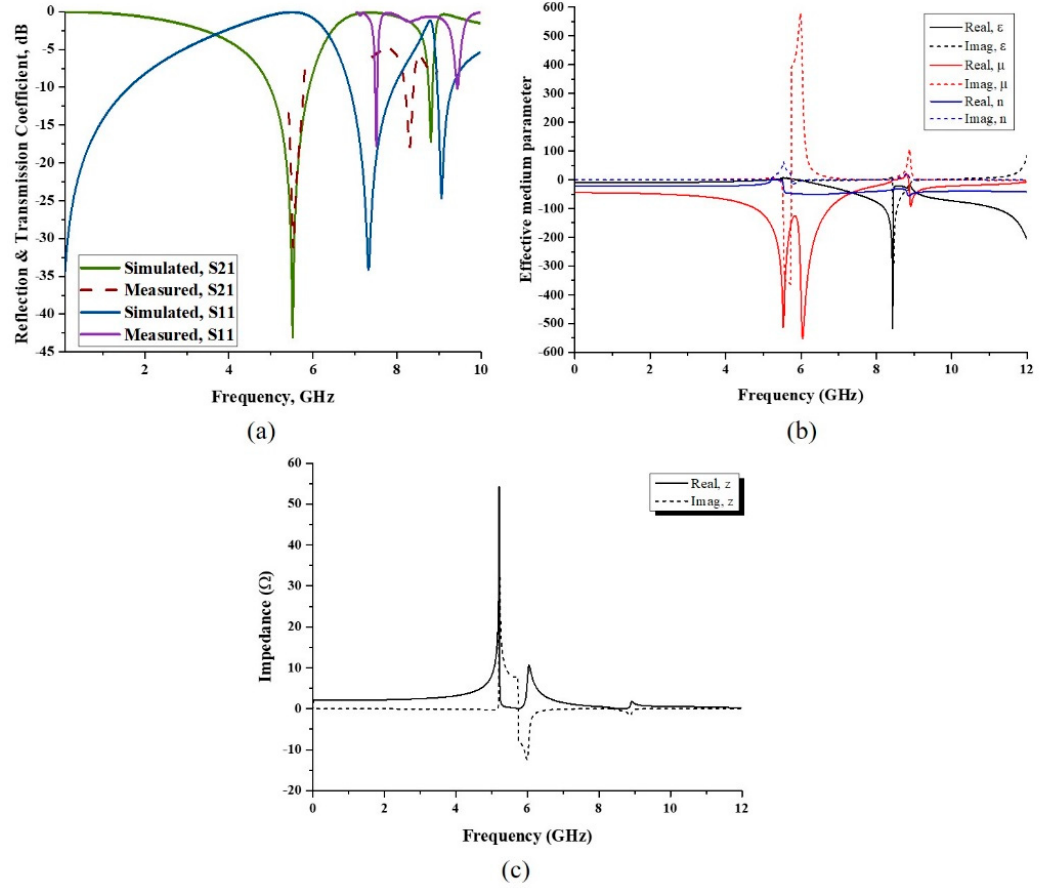
Figure 6. ( a ) Transmission (S 21 ) and reflection coefficient (S 11 ) of simulation and measured result, ( b ) simulation result for permittivity, permeability, and refractive index, and ( c ) impedance.